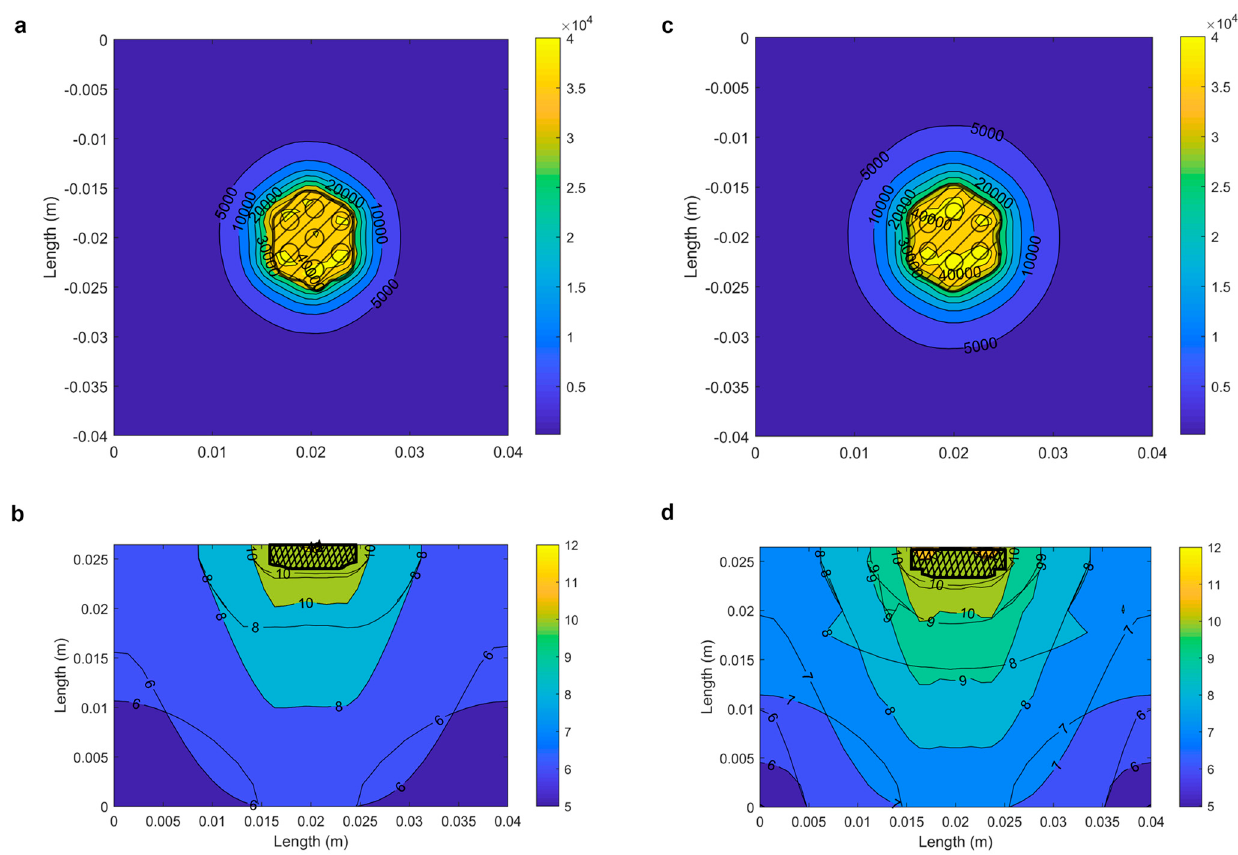
Figure 4. Electric field distribution for ( a ) the classical and ( c ) the proposed alternative pulse delivery protocol (V/m) 2 mm below the skin surface in the hypodermis, where the cells important for the immune response are located. The location of the electrodes is marked with circles. Side view of the natural logarithm of the electric field distribution (V/m) in the middle between the electrodes for ( b ) the classical and ( d ) the proposed alternative pulse delivery protocol. The shaded area shows the area of reversible electroporation. We chose the logarithmic representation as the electric field values differ for ranges and the differences would not be clearly seen otherwise.